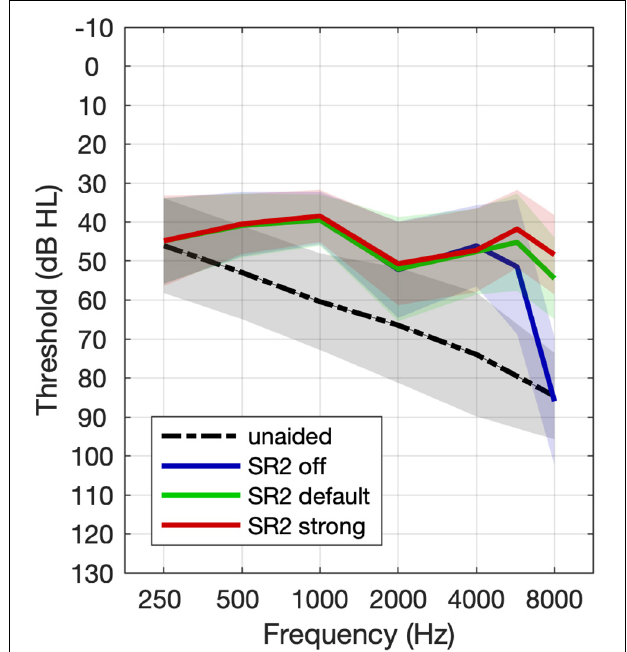
FIGURE 4 | Mean group unaided and aided hearing thresholds. The black line represents the unaided thresholds. The dashed line, the solid line, and the dotted lines represent free-field thresholds for the aided thresholds with SR2 off, SR2 default, and SR2 strong settings, respectively. The shaded area represents ± 1 S.D. of the